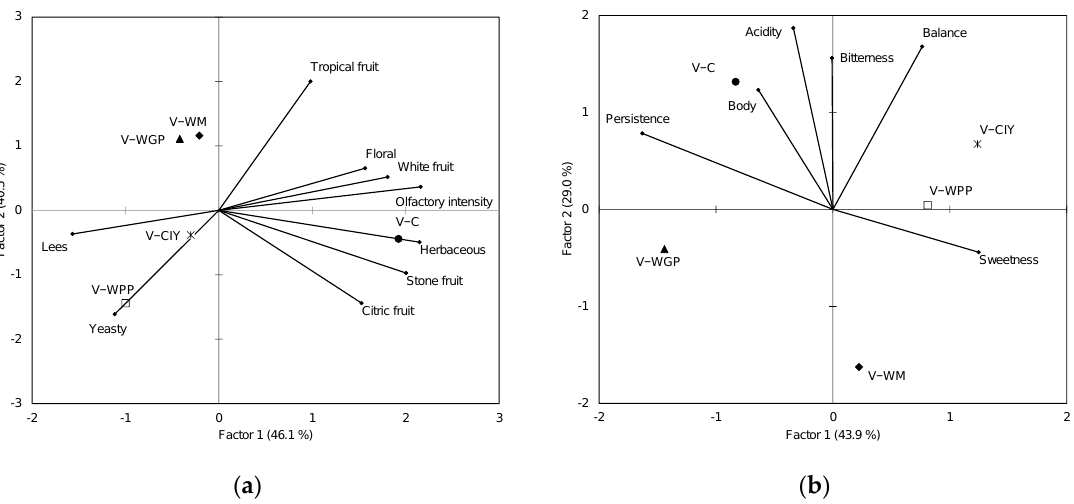
Figure 4. Generalized Procrustes analysis (GPA) of the mean ratings for ( a ) olfactory phase and ( b ) gustative phase in the Verdejo wines. C: control wines, WM: wines with the addition of PSs extracted from white must, WGP: wines with the addition of PSs extracted from white grape pomace, WPP: wines with the addition of wine purified polysaccharide rich in RG-II, CIY: wines with the addition of commercial inactivated